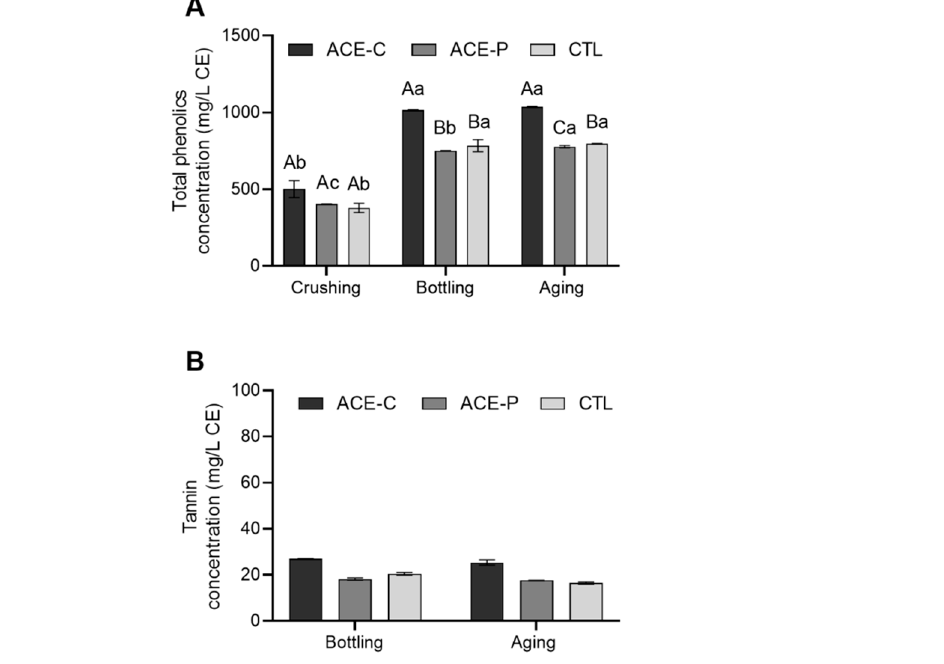
Figure 3. ( A ) Iron-reactive phenolic compounds content and ( B ) Tannin content in Marquette grape musts and red wines. The error bars represent standard derivation of the mean ( n = 2). Uppercase letters indicate significant difference ( p < 0.05) among treatments within same time point. Lowercase letters indicate significant difference ( p < 0.05) within same sample over time.